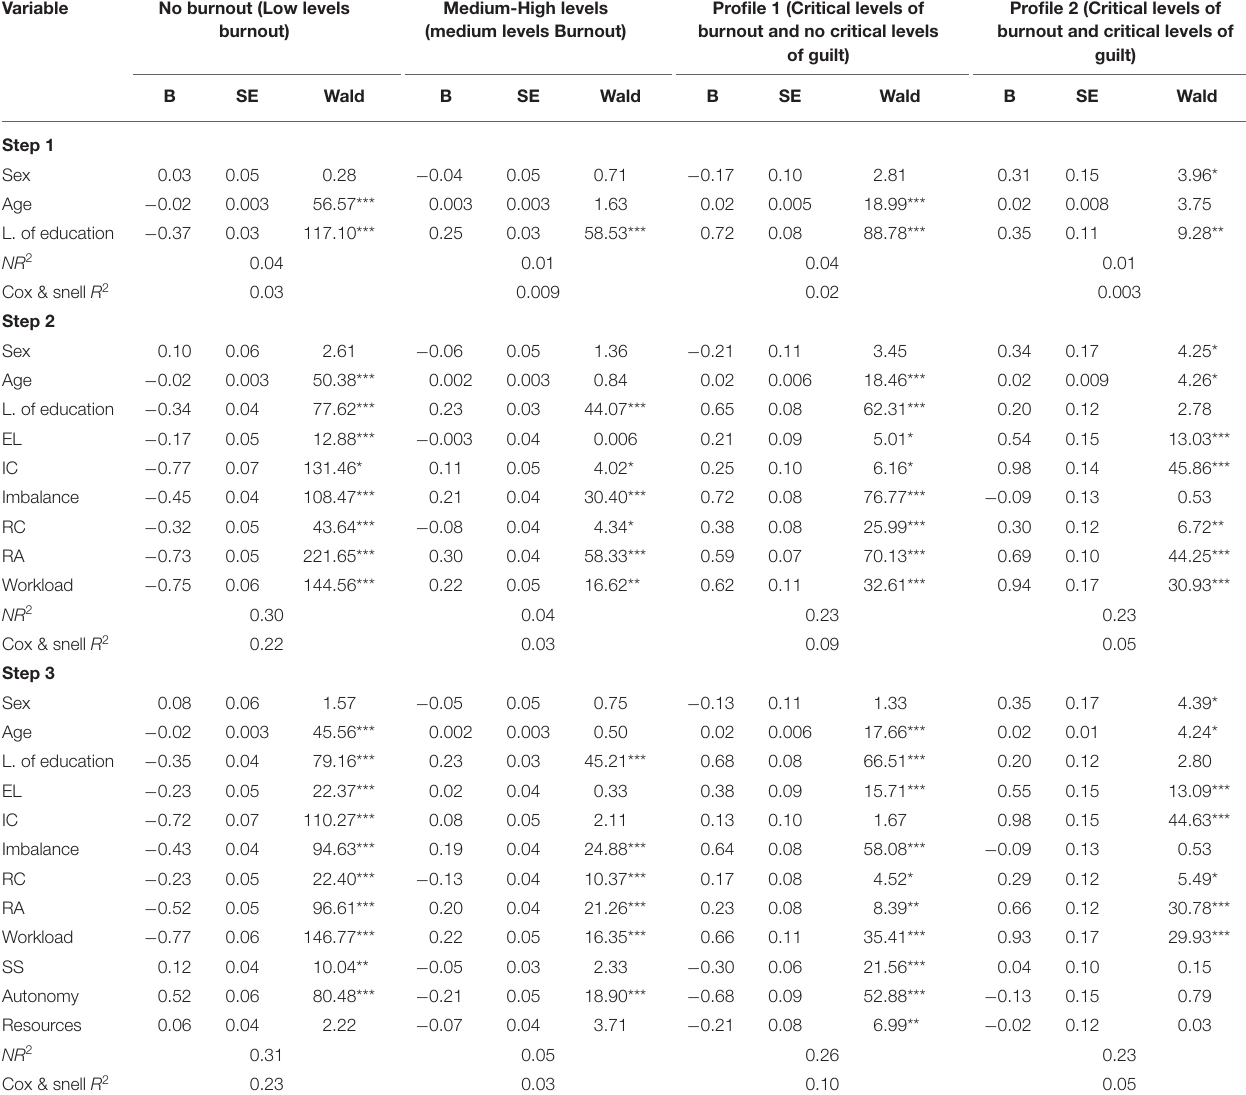
TABLE 2 | Logistic regressions for no burnout, medium-high levels, profile 1, and profile 2.